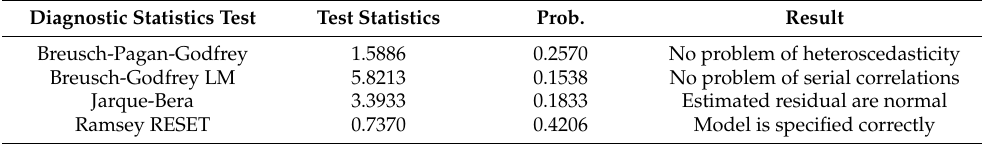
Table 4. Residual and Stability